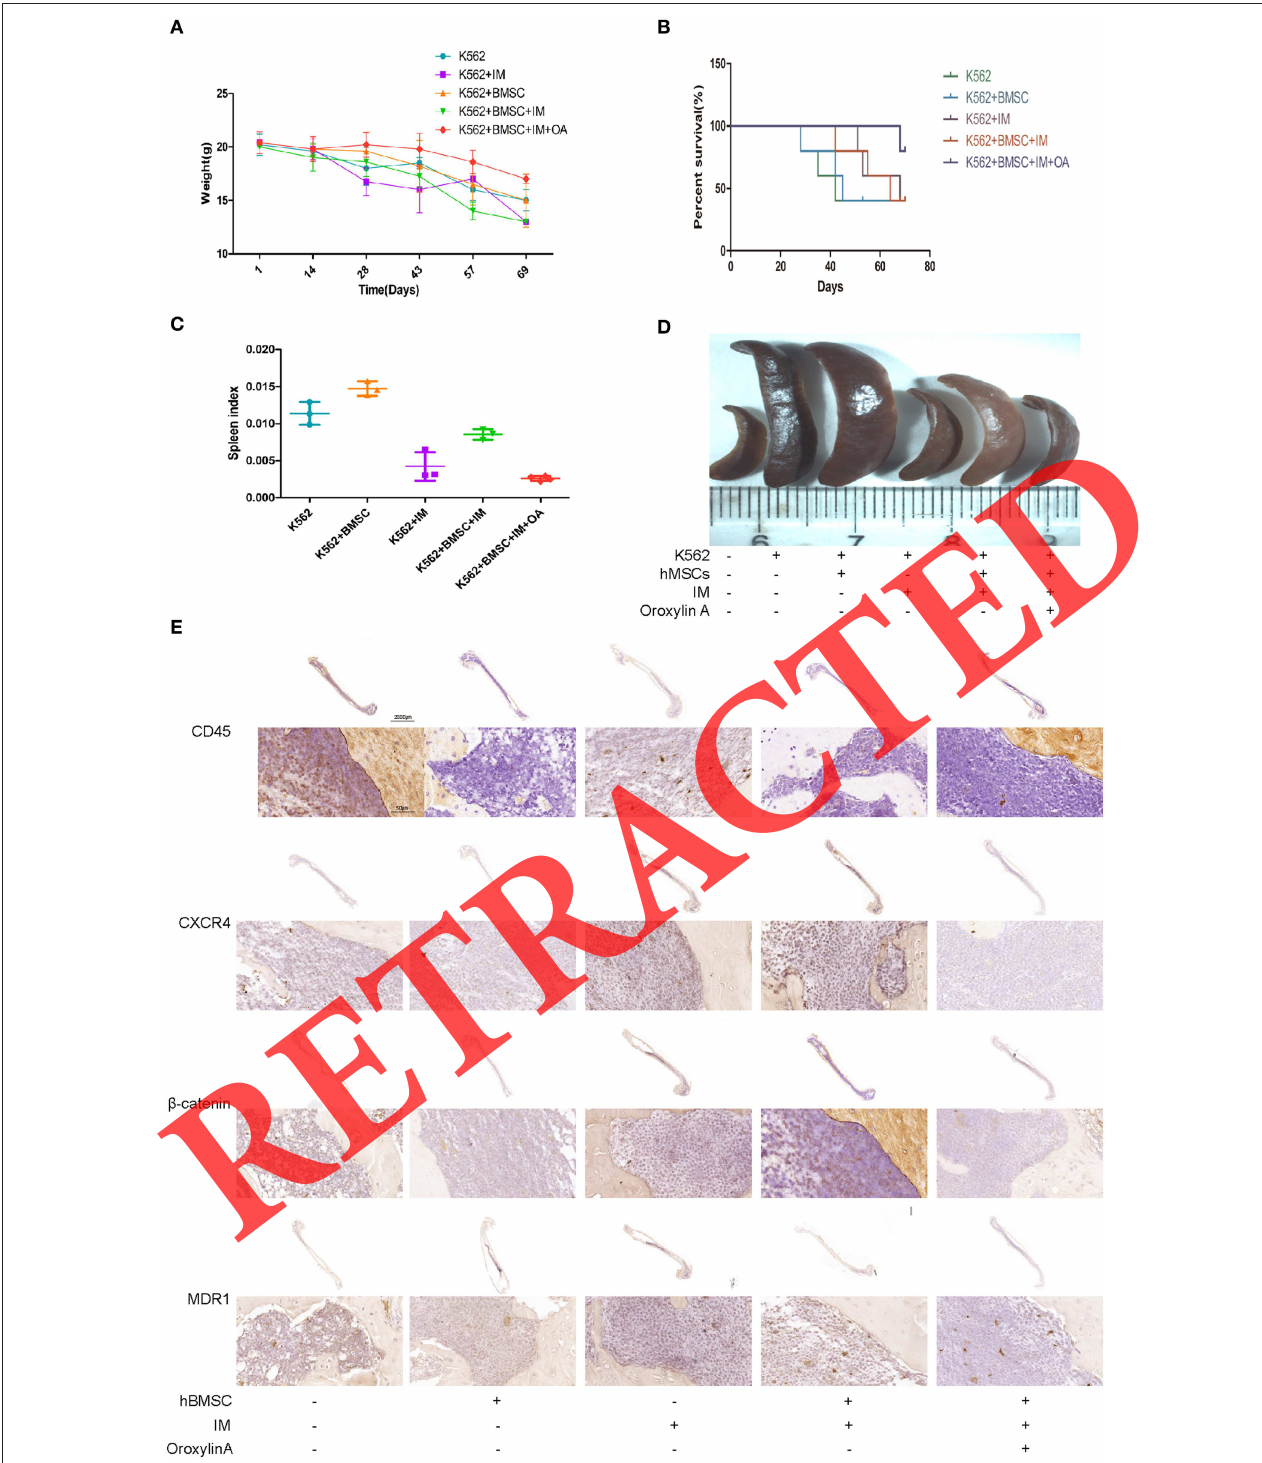
FIGURE 6 | The reversal effect and mechanisms of Oroxylin A in vivo . Tumor xenografts inoculated with K562 cells or combinations with hBMSCs were treated with IM (200 mg/kg) or combination with Oroxylin A (80 mg/ kg) every other day orally for 4 weeks. (A) The analysis of body weight after indicated. (B) Survival Curves of mice after different treatment. (C) The weight of spleens of treatment groups. (D) Images of representative spleens. (E) Representative IHC staining of murine BM, for human CD45, β -catenin and P-gp antigen.